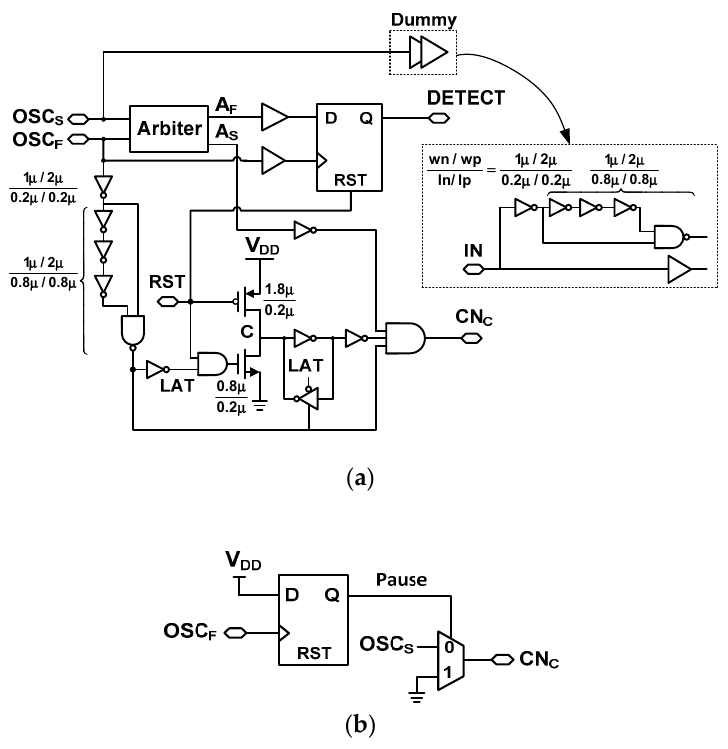
Figure 9. ( a ) Schematic of the proposed alignment detector, ( b ) alternative approach to generate CN C